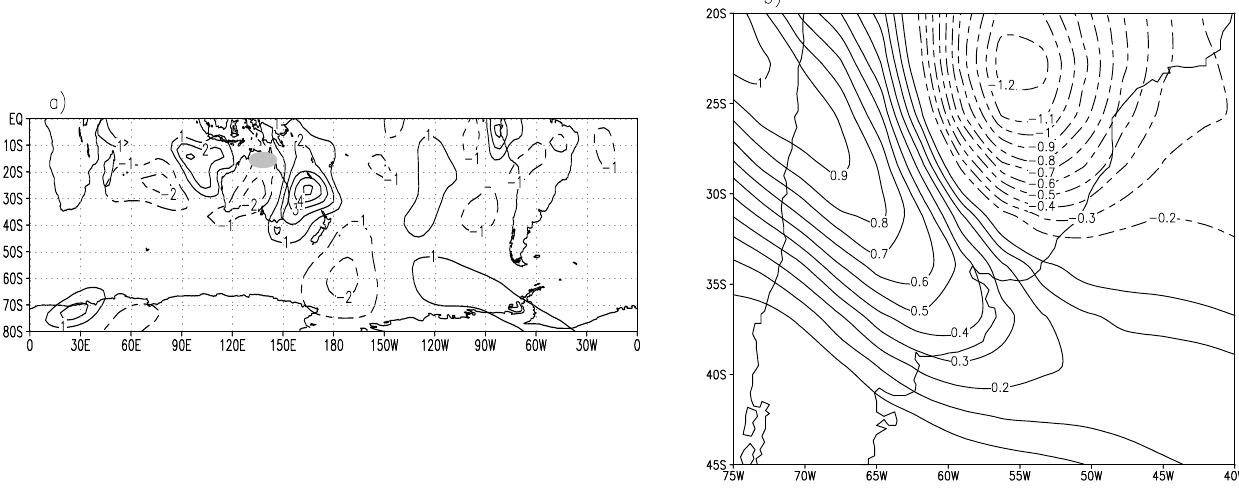
Fig. 8. (a) Meridional wind component anomalies (ms − 1 ) at 250hPa and (b) surface temperature anomalies ( ◦ C) on day 10 of integration, corresponding to + σ basic state experiment with forcing at 140 ◦ E–15 ◦